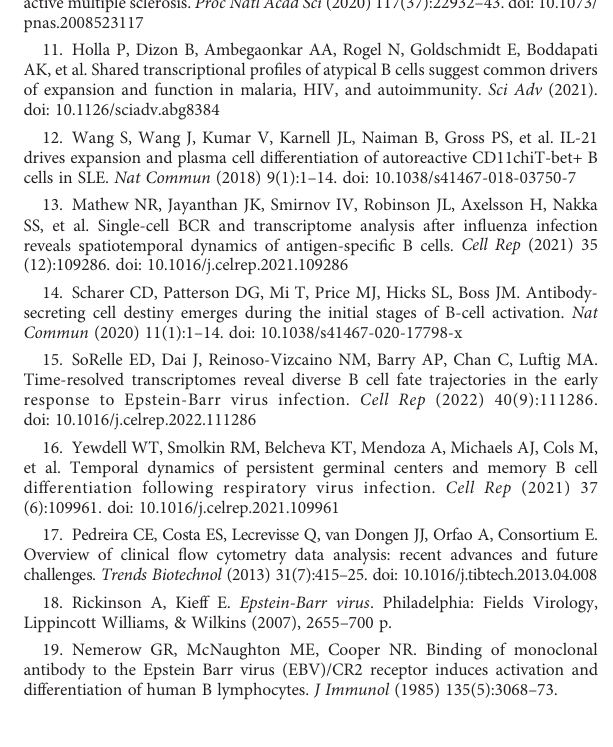
dataset. (B) Top markers within late plasma cells (ASCs). Data are presented for three LCLs generated in-house (left column) and commercially available LCLs (GM12878, middle column; GM18502, right column) originally reported by Osorio et al (112). SUPPLEMENTARY FIGURE 5 KeymarkergenesinlyticcellsacrossLCLs.Datafromdifferentiallyexpressed genes of interest are presented for three LCLs generated in-house. SUPPLEMENTARY FIGURE 6 Expression signature of atMBCs within LCLs. (A) Pearson R correlations for single-cell co-expression of the atMBC markers TBX21 , FCRL5 , and CXCR3 in LCLs. (B) Data from differentially expressed genes of interest are presented for three LCLs generated in-house and commercially available LCLs (GM12878, GM18502) originally reported by Osorio et al (112). Three of fi ve LCL datasets contain cells consistent with atMBCs exhibiting elevated expression of key receptors that mediate atMBC responses to stimuli in addition to AP-eMBC characteristics (identi fi ed by greencircles). CellswithAP-eMBC characteristicsbutlacking de fi nitive atMBC gene expression in the remaining two LCLs are also highlighted (blue circles). SUPPLEMENTARY FIGURE 7 Additional replicates for FACS studies of EBV-associated autoimmune phenotypes in LCLs and de novo infection. (A) FACS replicates for CD23 (FCER2) downregulation upon stimulation with R848 and/or IL-21. (B) FACS staining of IgD and CD27 in uninfected peripheral B cells to identify putative double negative (DN) B cell frequencies. Samples were prepared via B cell enrichment (negative isolation) from PBCMs. Data are presented for two donors. (C) Biological replicate for cell proliferation and CXCR3, CD11c, FCRL4 staining in de novo infection